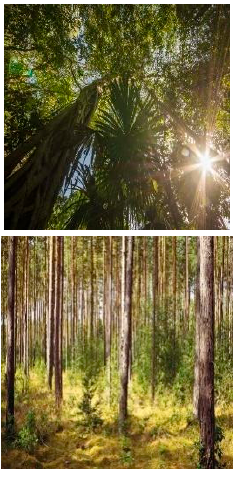
Figure 8. Examples of sunlight with different weather and season images in the dataset.